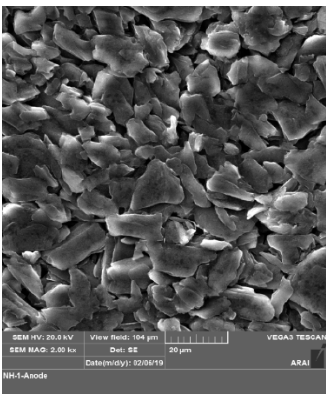
Figure 3. New cell anode.